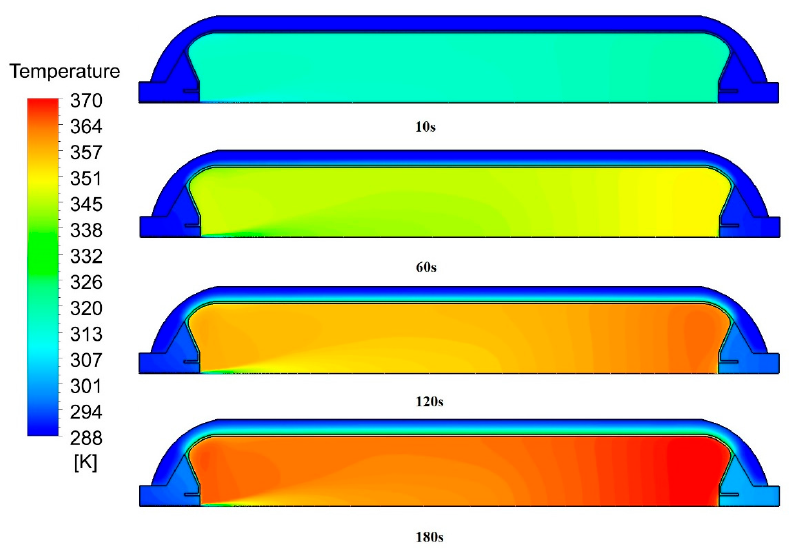
Figure 6. Temperature distributions at 10, 60, 120, and 180 s.